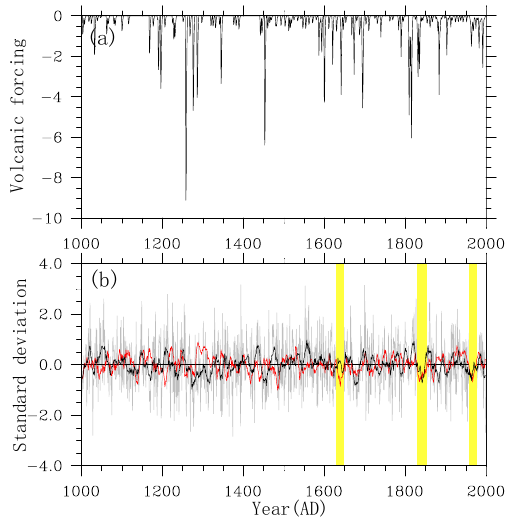
Figure 9. Volcanic forcing series used by the model shown in Wm − 2 (a) . Time series of standardized anomaly variations of rainy season precipitation rate derived from the volcanic forcing run (b) . Annual anomalies (gray curve) are shown along with smoothed ver- sions using a 10-year running average (black curve). Red curve presents the 10-year running mean time series of standardized anomaly variations of rainy season precipitation rate derived from the full forcing run. The droughts that occurred during 1631–1648, 1830–1853 and 1958–1976 are shown with shaded bars.